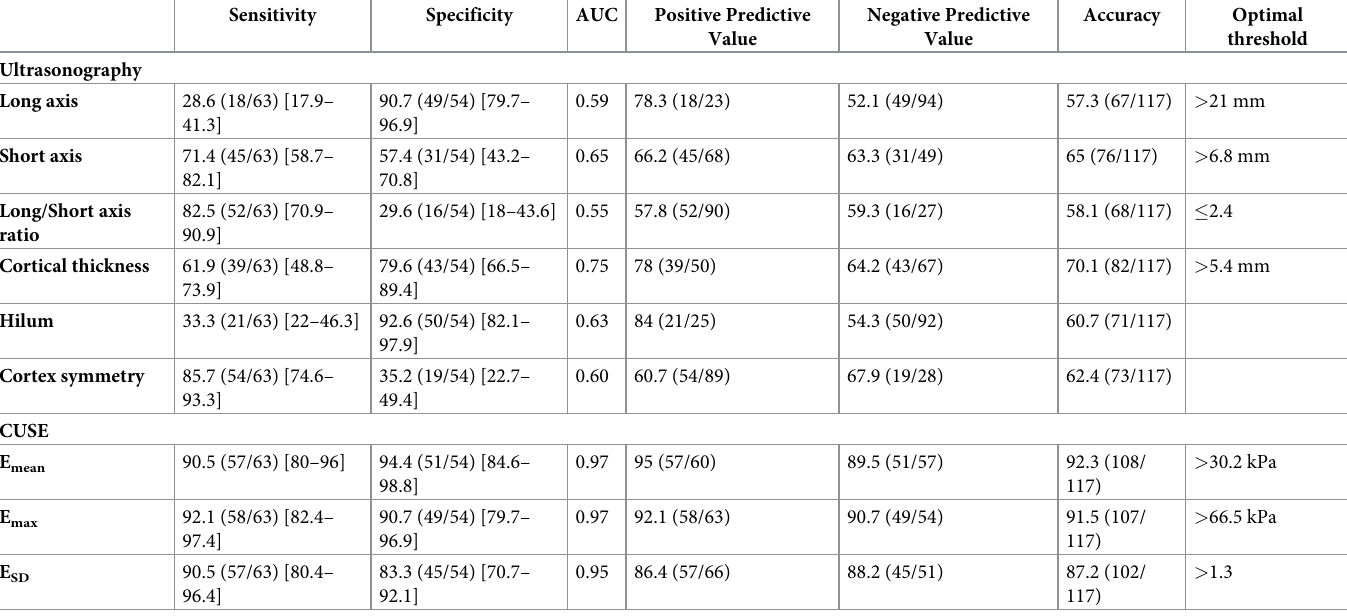
Table 2. Performance of conventional ultrasonography and CUSE in the assessment of reactive and metastatic